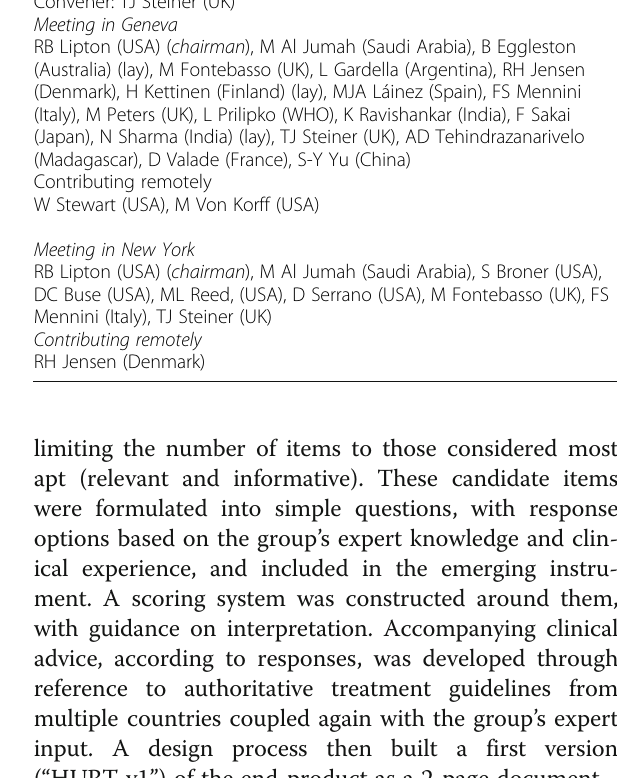
Convener: TJ Steiner (UK) Meeting in